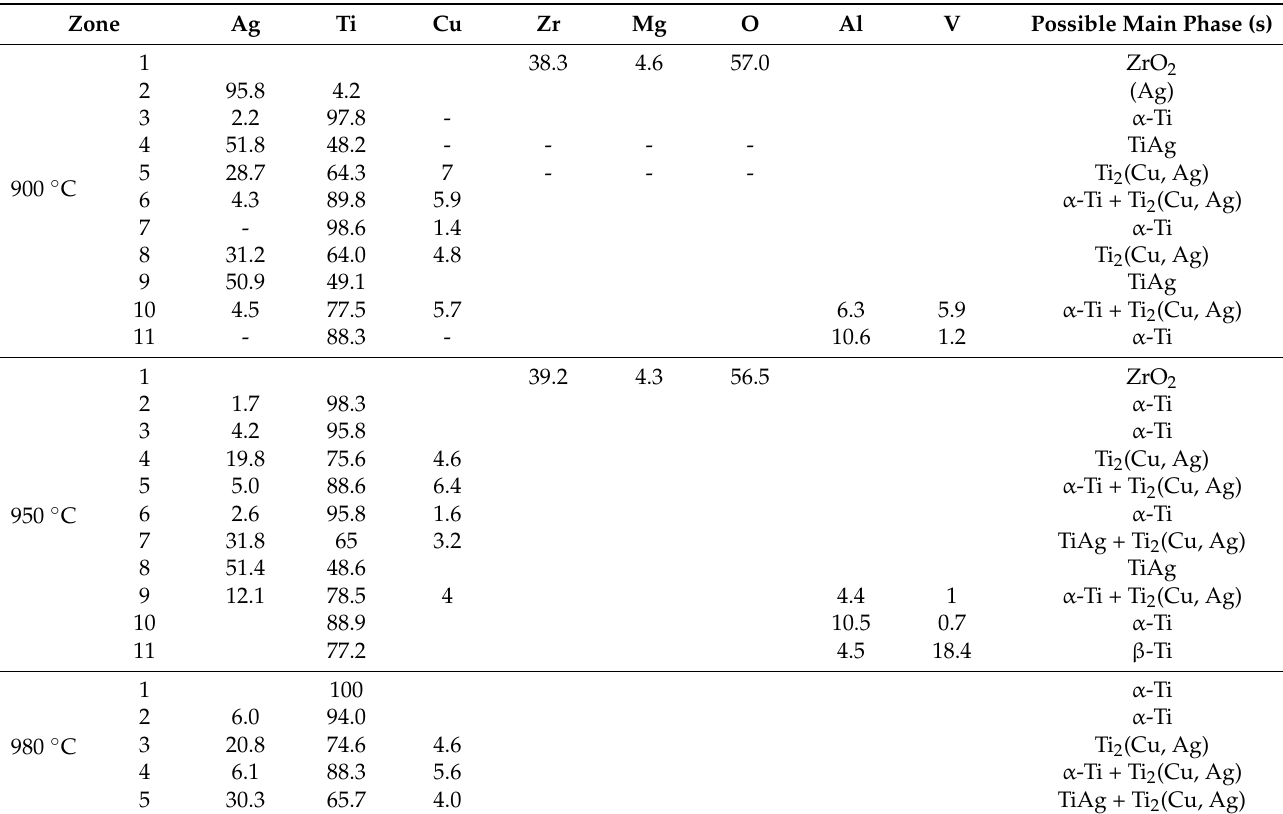
Table 1. EDS chemical composition (at.%) of the zones of interest is illustrated in Figure